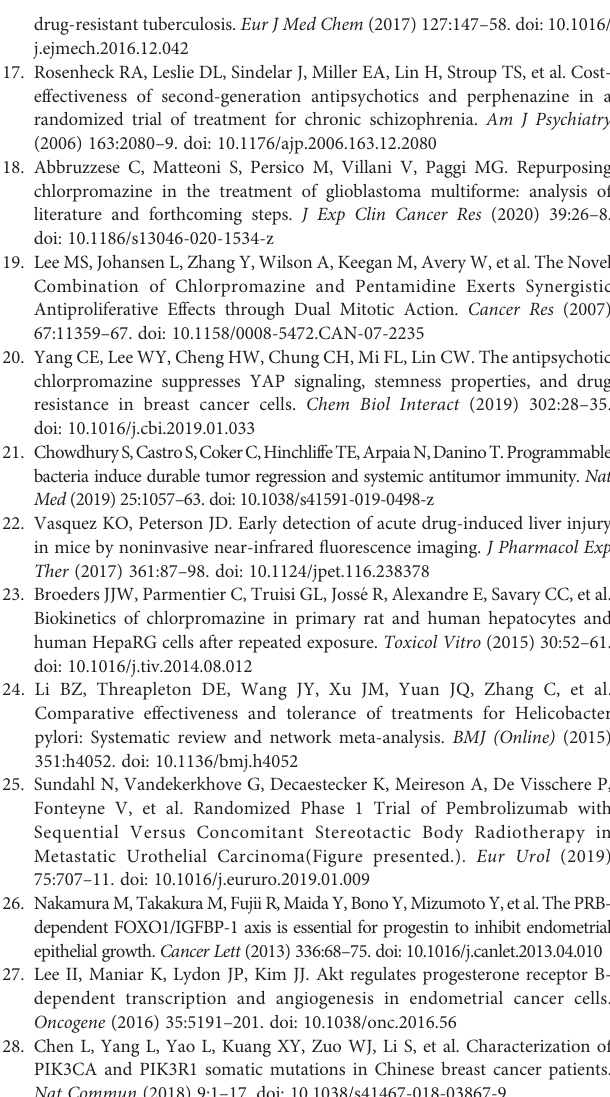
Supplementary Table 1 | Proliferation inhibition of 20 tricyclic antipsychotic drugs in ISK cell lines. Supplementary Figure 1 | The proliferation curve of ISK and KLE cells. ISK and KLE cells were treated with different concentration of MPA and CPZ for 24,48 and 72h. Data are shown as the mean ± SEM; n = 3. Supplementary Figure 2 | CPZ sensitizes KLE cells to MPA by upregulating PRB. (A)Schematic representation of the sequential treatment on KLE cells. (B-C) Pre-treatment with 5 m M and 10 m M CPZ for 48h, KLE cells then were incubated with various concentrations of MPA for 48h. (D) CPZ upregulated the protein level of PRB in KLE cells treated with 5 m M CPZ for 48h. (E) The transfected ef fi ciency was measured by Western Blot. Results are presented as mean ± standard error of the mean and error bars represent the SD of three independent experiments.